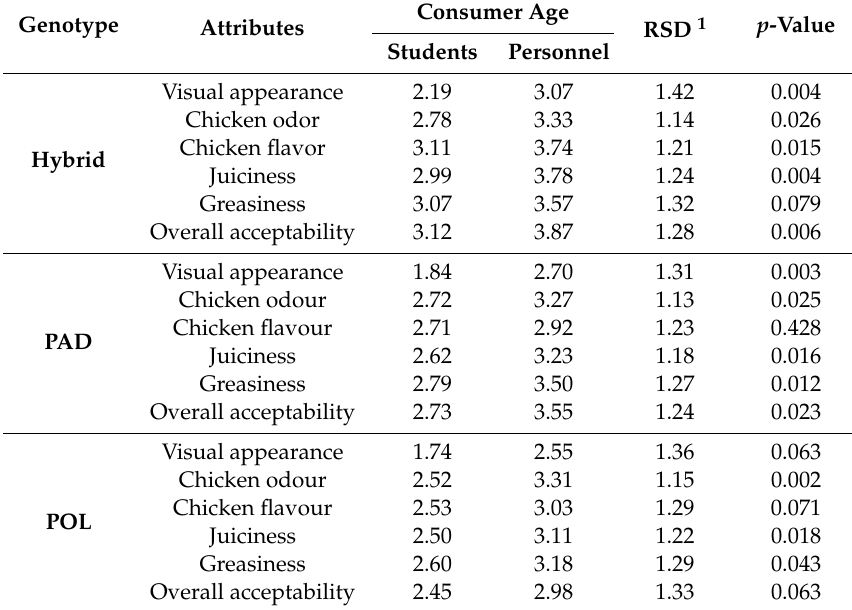
Table 8. Consumer preference analysis of leg meat from Hybrid, PAD, and POL genotypes according to consumer age: Students (age < 21 years old) and personnel (age > 35 years old).